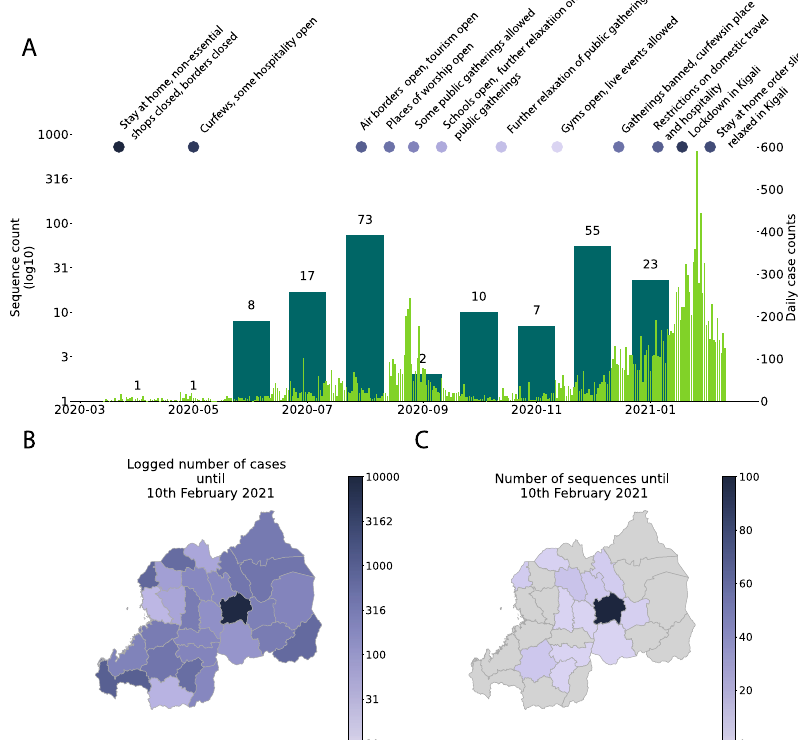
Fig. 1 Comparison of the number of sequences taken and case counts over time and space. A time series of month of sequence collection date (thicker bars), with thinner bars the daily new cases reported nationally until the 10 th of February, 2021. Control measures are shown above the time series as colored dots, with darker colors representing more restrictions; B shows the number of sequences in this study by the district of residence; C log- transformed number of cumulative cases by the district until the 10 th of February,